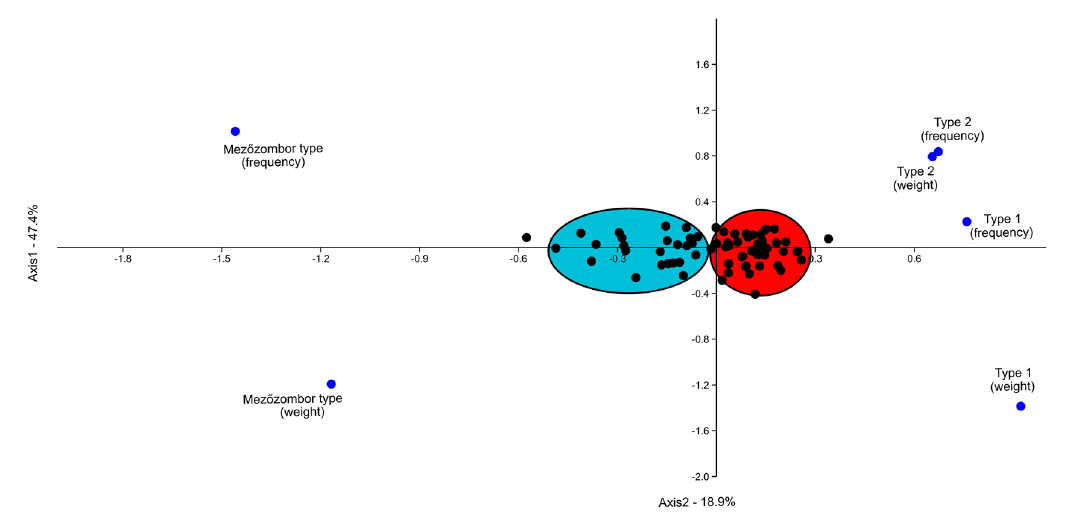
Figure 15: Correspondence analysis of the three main raw material types (Type 1, Type 2 and Mezőzombor type limnosilicite). Note the two clusters of the points in the middle of the plot.